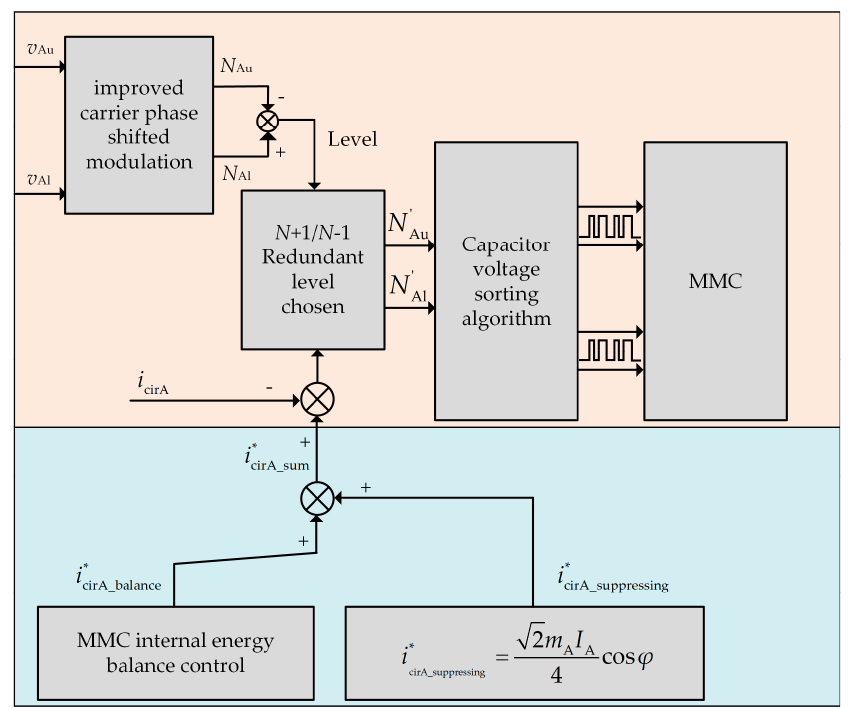
Figure 12. The block diagram of the circulating current suppression strategy based on the improved 2 N +1 pulse-width modulation approach. 2 N +1 pulse-width modulation